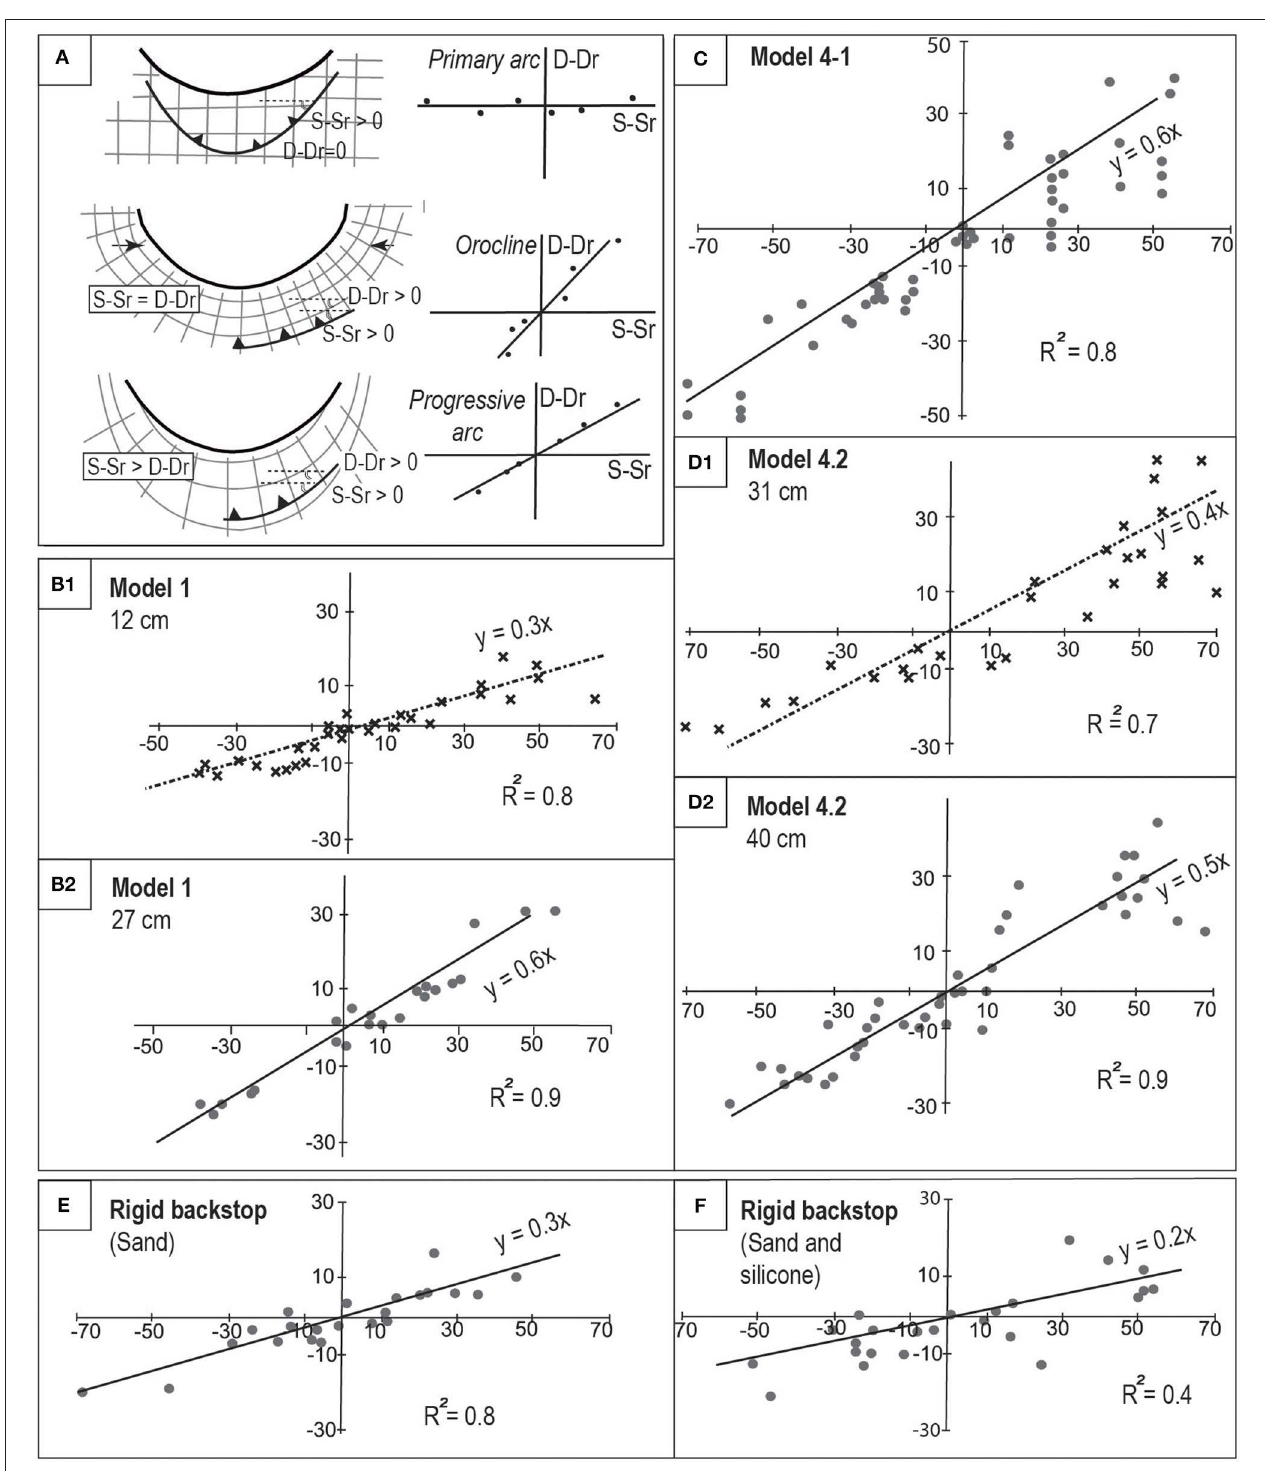
FIGURE 11 | (A) Sketch of the paleomagnetical orocline test applied to our models. ( B1, B2) Oroclinal test for Model 1 at early and final stages. (C) Oroclinal test for Model 4-1 at final stage. (D1, D2) Oroclinal test for Model 4-2 at early and final stage. (E,F) Oroclinal test for models of sand and silicone–sand of Crespo-Blanc and González-Sánchez (2005),